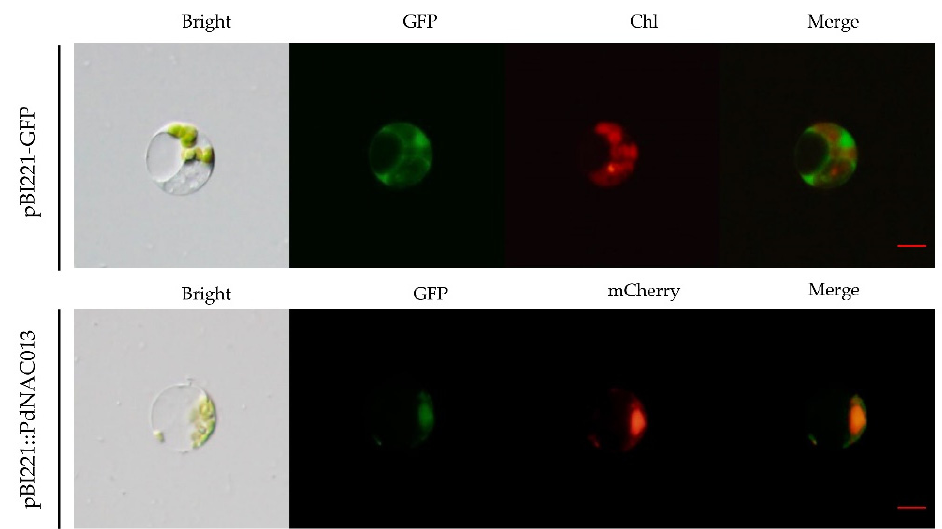
Figure 7. Subcellular localization of PdNAC013. The fusion protein pBI221::PdNAC13 and D53- mCherry (nuclear localization), pBI221-GFP (control) constructs were transiently expressed in NL895 poplar protoplasts and visualized with fluorescence microscope. Scale bar, 5 μ m.